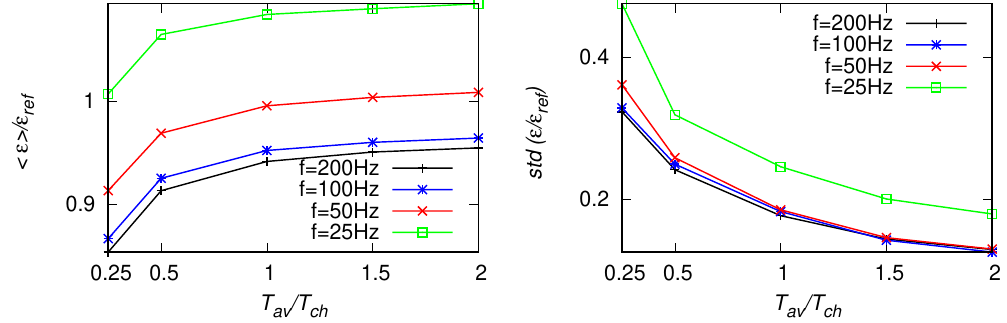
Figure 17. As in Figure 16, but for the fitting range f = [ 5 ÷ 10 ]